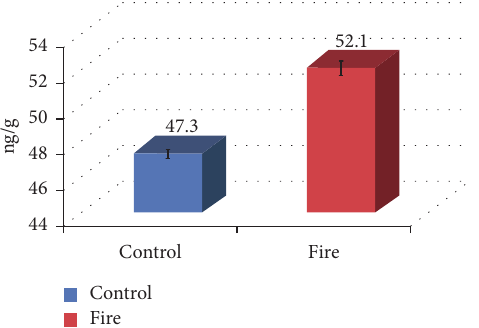
Figure 6: Sum of PAH content in folic horizons of control and fire- affected soils: Folic and Folic pyr , respectively (O and Opyr, respectively).